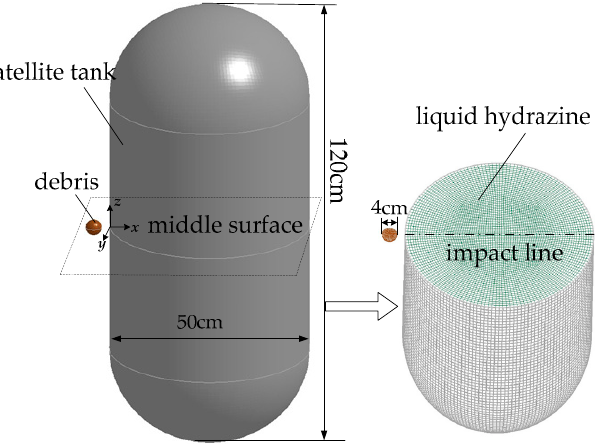
Figure 8. The simulation model of the debris impacting the satellite tank and the right side is the model cut in half.